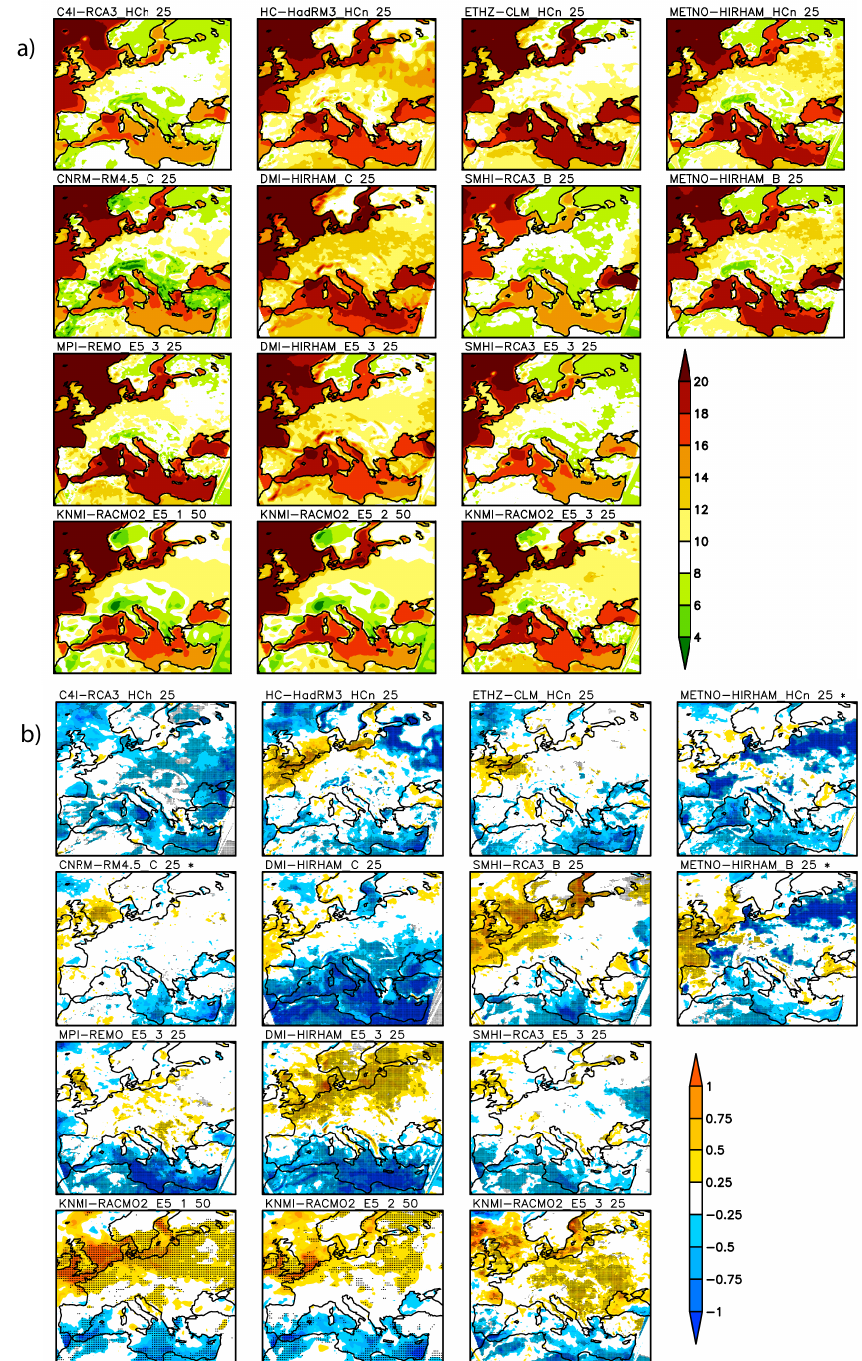
Fig. 5. 98th percentile of daily maximum wind speeds (WIMAX) in the RCM simulations. 1st row: driven by the (different) HadCM3 simulations, 2nd row: driven by CNRM-CM3 or BCCR-BCM2, 3rd row and 4th row: driven by MPI-ECHAM5 (run 1, 2 or 3). (a) Absolute values for the 20C period (1961–2000), (b) projected changes for 98th percentile of WIMAX in the RCM simulations; all results are for the future period 2071–2100, except for METNO HIRHAM HCn*, METNO-HIRHAM B* and CNRM-RM4.5 C* (only integrated until 2050) changes are presented for the period 2021–2050. Magnitude of change is shown by coloured areas (unit: ms − 1 ), black dots indicate statistical significance above 0.95 (Student’s